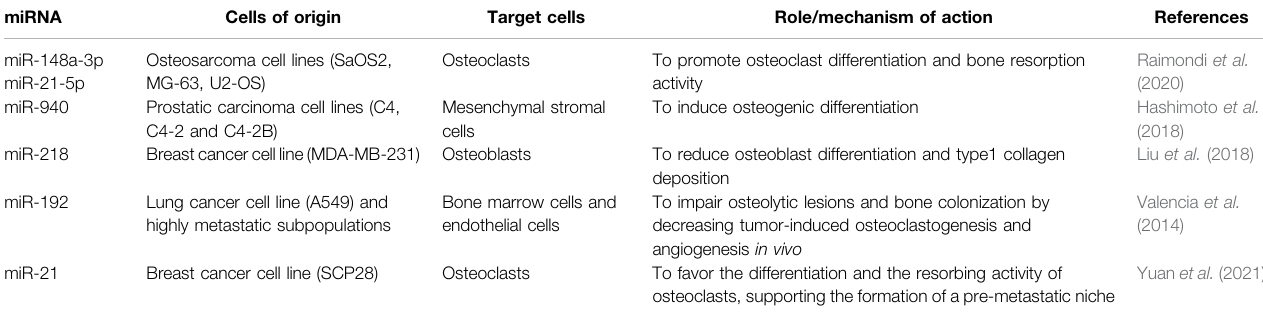
TABLE 1 | List of cited miRNAs conveyed as EV cargo and involved in the crosstalk between EVs and mechanoenvironment in bone